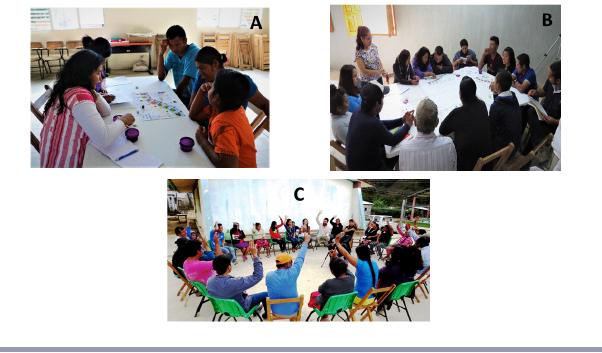
Fig. 6. Rural families playing The Flow of Peasant Lives. (A) Single-family session. (B) Multifamily session. (C) Debriefing